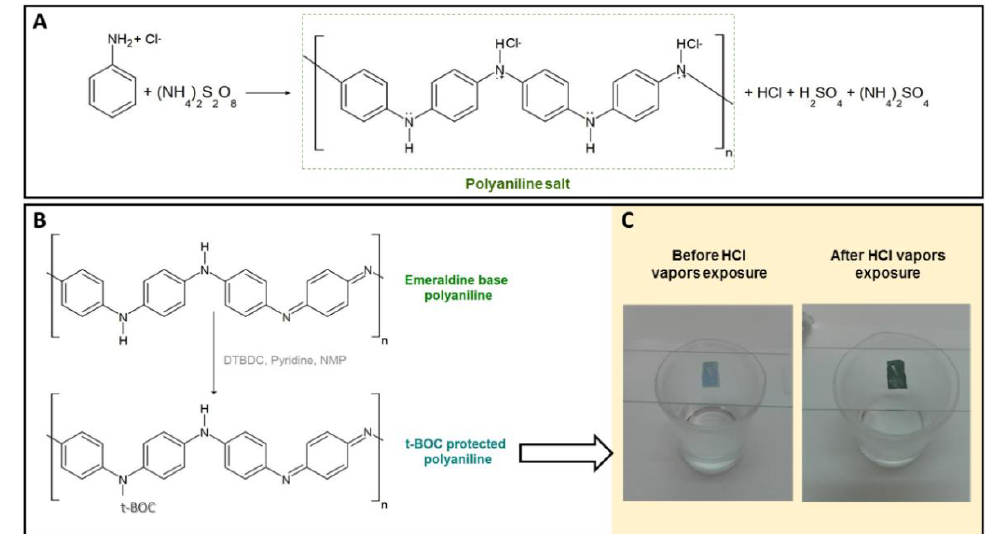
Figure 1. Resume of experimental details: ( A ) Synthesis of PANI powders by chemical oxidative process; ( B ) Chemical substitution of one of the imine groups for a t-Boc-protective group; ( C ) Illustrations of t-Boc removal process and consequent protonation of PANI membrane.